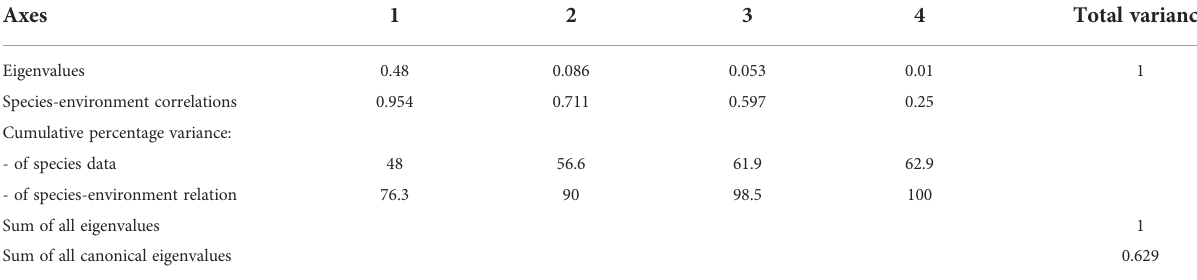
TABLE 3 Summary of the results of the redundancy analysis (RDA) between environmental variables and dominant specie in the middle bay. Axes